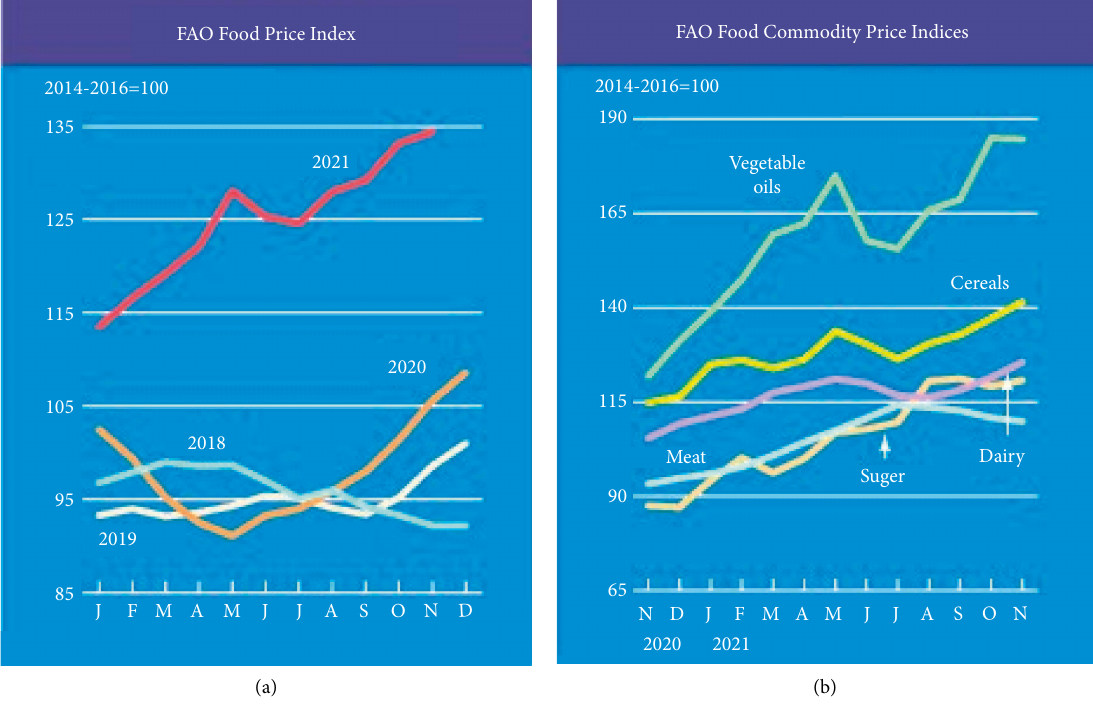
Figure 1: Trajectories of FAO indices for FPI (a) and its constituents (b) (source: FAO